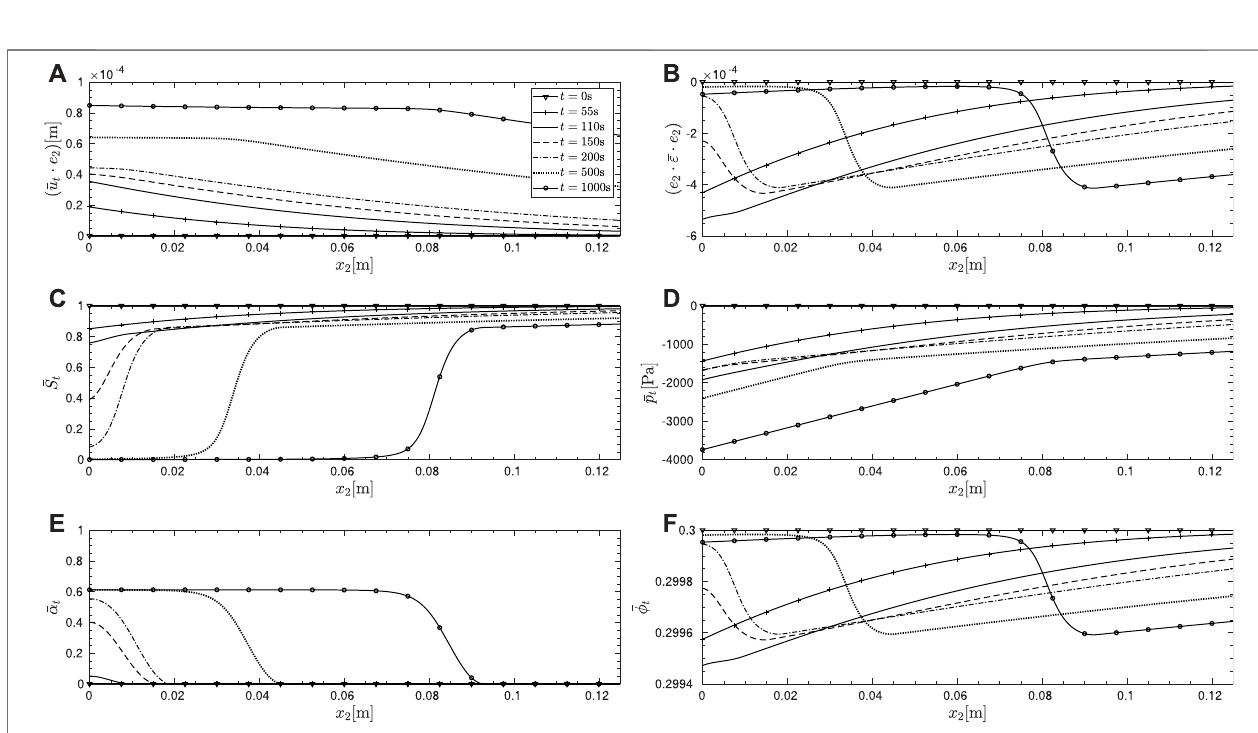
FIGURE 4 | Evolution in Figure 3 shown within a restricted computational domain, ~ Ω (cid:2) ( 0 , 0 . 05m ) , close to the drying boundary for clarity.